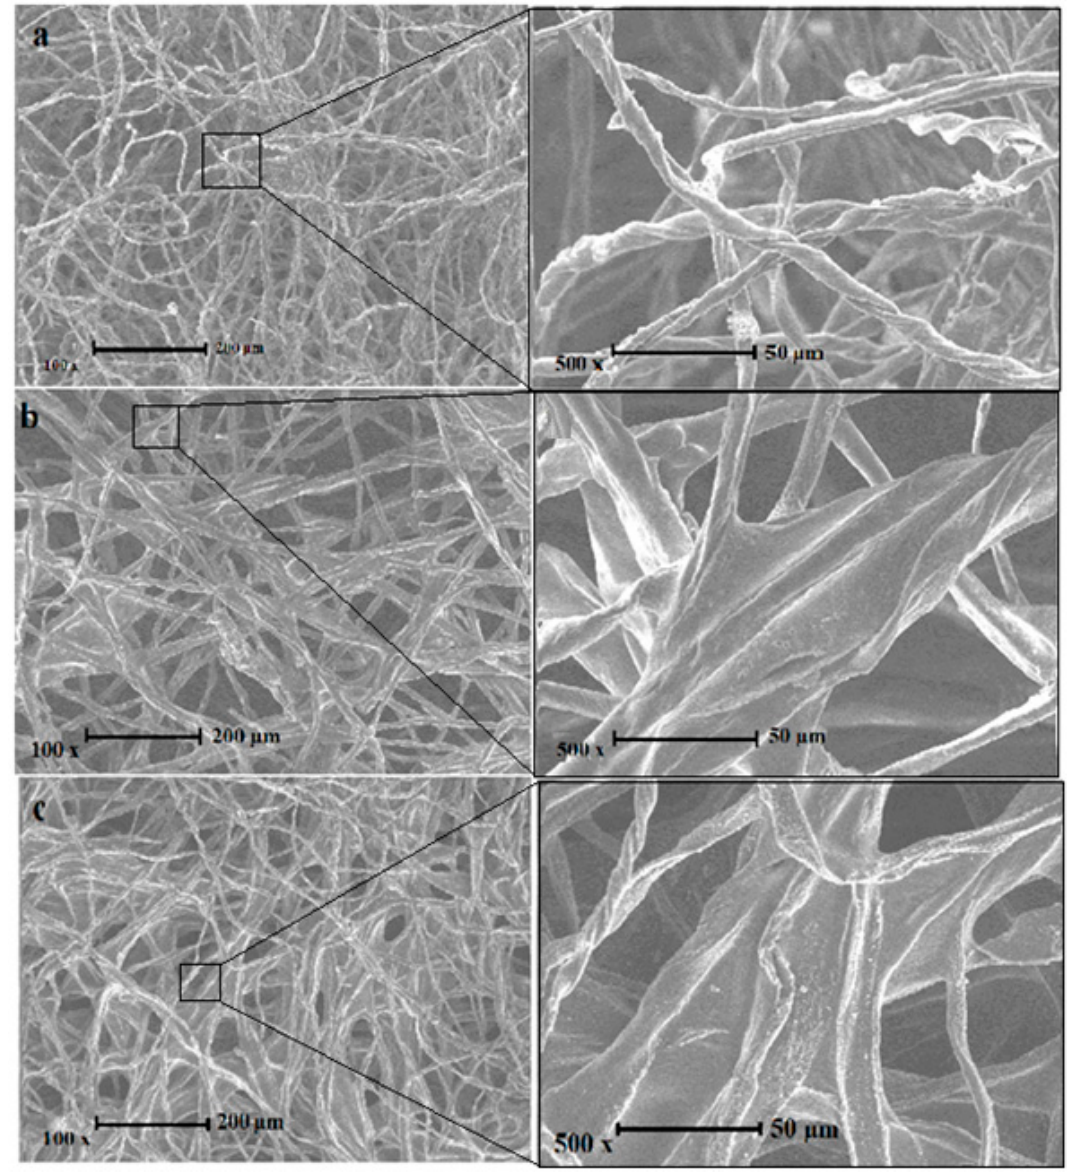
Figure 2. SEM images of synthesized carbon materials: ( a ) NC; ( b ) PhR/NC-1 and ( c ) PhR/NC-2.